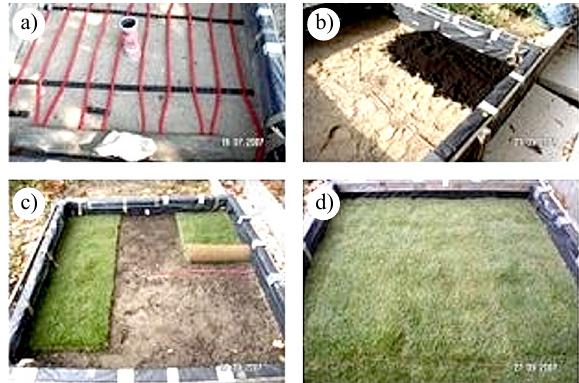
Fig. 5. Images of particular works during the construction of experimental setup: a – fixing pipes; b – surface with thermal sensor; c – cover with grass; d –